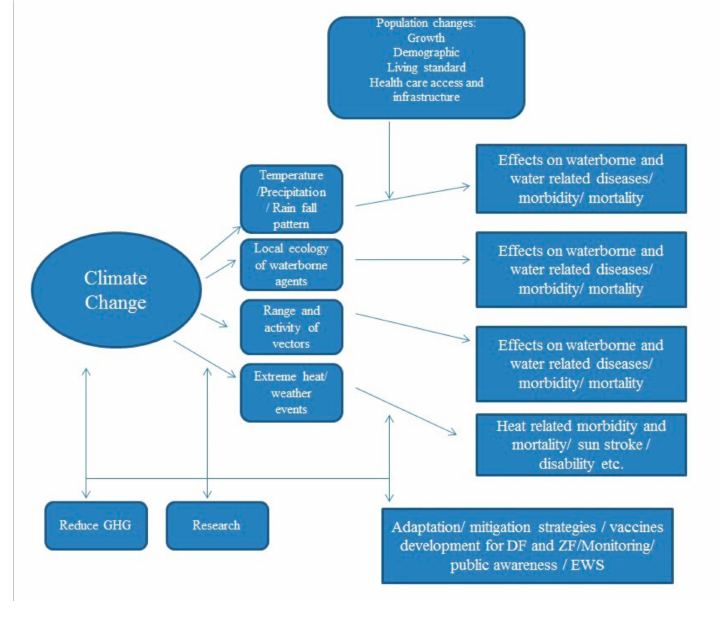
Figure 1. Health impacts of climate change (adapted from